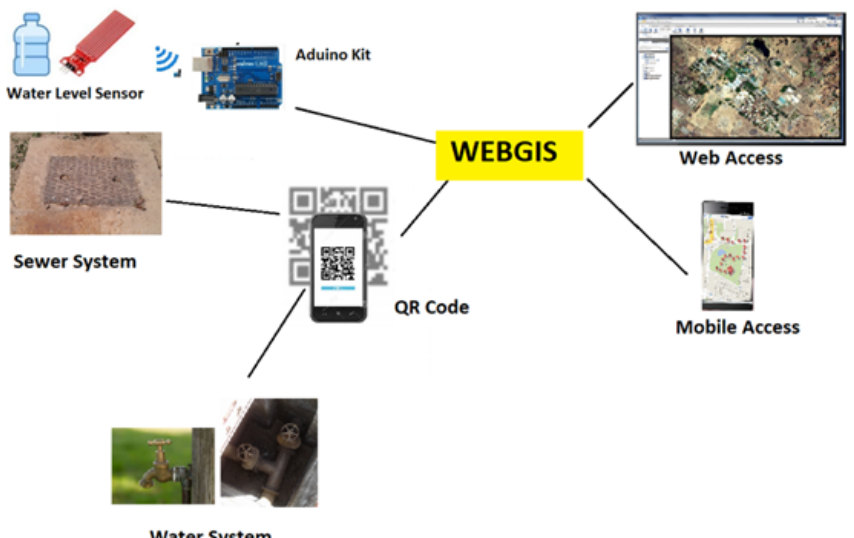
Fig. 5. Summary of the proposed